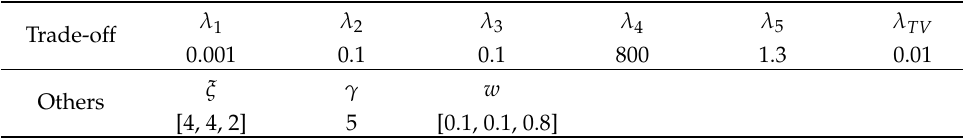
Table 6. The values of each parameter in HTSR